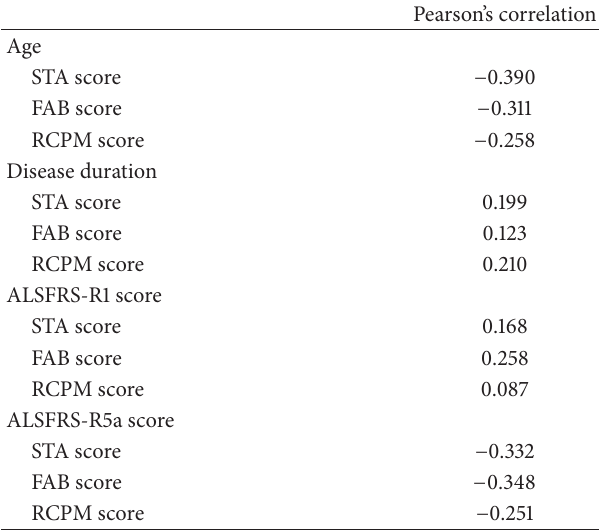
Table 4: Correlation between demographic variables and results of STA, FAB, and RCPM.